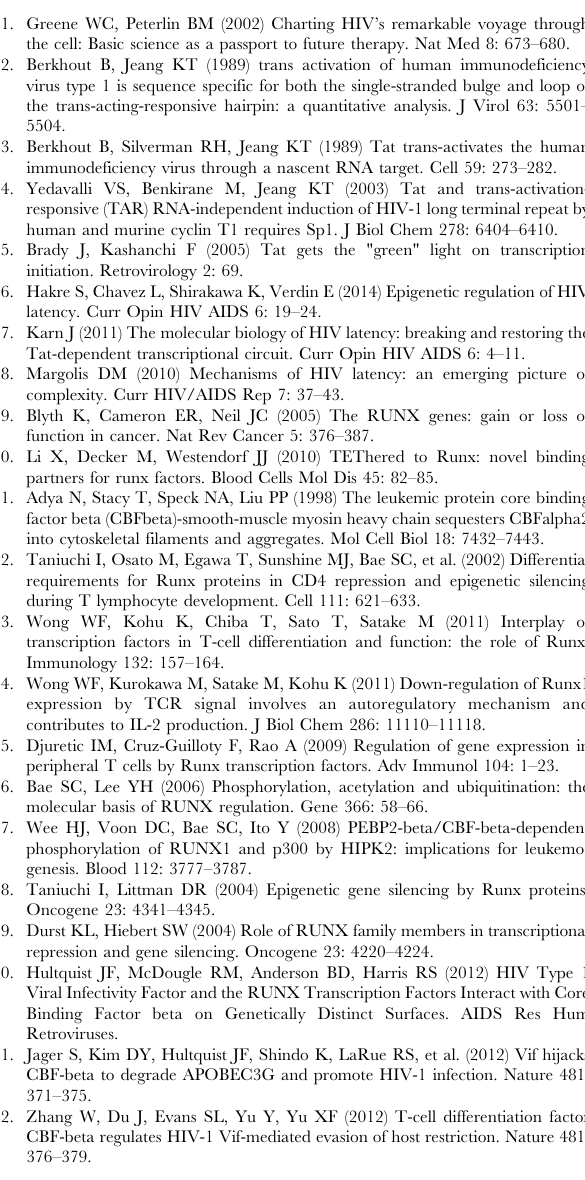
Figure S5 Reactivation with SAHA, ValproA or Ro5- 3335. ACH2 cells were treated with increasing concentrations of PMA (0, 1, 10 uM), SAHA (0, 1, 10 uM), ValproA (0, 1, 10 mM) and Ro5-3335 (0, 5 and 50 uM). Forty-eight hours post transfection viral production was determined by RT assay on the cell culture supernatant. Figure S6 Toxicity of SAHA and Ro5-3335. A) JLat, B) ACH2, C) TZMbl or D) J-LTR-G were cultured with increasing concentrations of Ro5-3335 and SAHA as indicated. Forty-eight hours post treatment cells were stained with Trypan Blue and cell the percentage of live cells was determined by light microscopy.